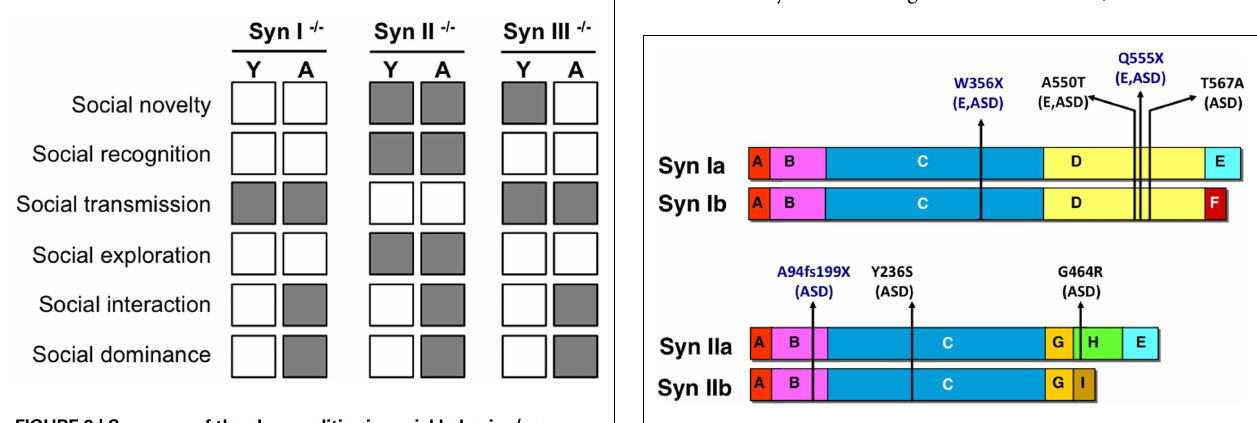
FIGURE 2 | Summary of the abnormalities in social behavior (gray squares) observed in young (Y, 2-month old) and adult (A, 6-month old) Syn I, Syn II, and Syn III KO mice with respect to the behavior of age-matched controls sharing the same genetic background [data from Ref. (65)] . Adults, but not young, Syn I and Syn II KO mice are epileptic.